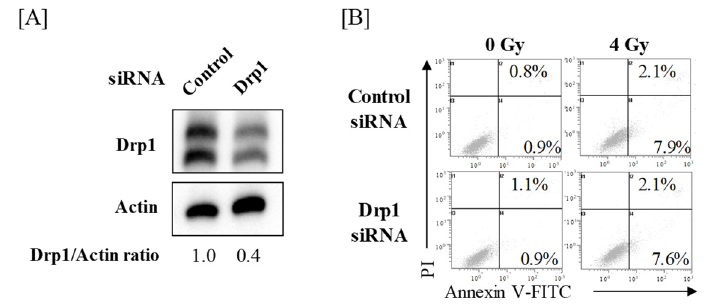
Figure 2. Effects of Drp1-knockdown on IR-induced cell death in A549 cells. ( A ) A549 cells transfected with control or Drp1 siRNA were harvested, and the Drp1 protein expression was analyzed by western blotting. Representative images of immunoblots are shown. Actin was used as a loading control. The relative values of Drp1/actin ratio are presented. For the Drp1 proteins, both bands were quantified together. ( B ) Drp1-knockdown A549 cells were treated with 4 Gy. After culturing for 72 h, the cells were harvested for cell death analysis using annexin V-FITC/propidium iodide (PI) staining. Representative cytograms of annexin V/PI staining are shown. The inset numbers indicate the fractions of annexin V+/PI − or annexin V+/PI+ cells.